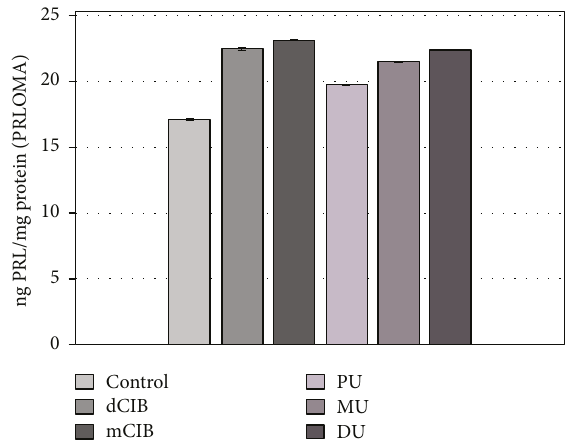
Figure 6: E ff ects of EDC on PRL release in rat PRLOMA cultures, in vitro . Mean (PRL/prolactin/level) ± SEM. The mean and SEM are calculated from n = 12 . Abbreviations: dClB =1,4- dichlorobenzene: 0.1ng/ml; mClB=chlorobenzene mix: 0.1ng/ml; PU=phenuron: 10 − 6 M; MU=monuron: 10 − 6 M; DU=diuron: 10 − 6 M. All EDC groups di ff er signi fi cantly from the control ( p < 0 001 ) for basal